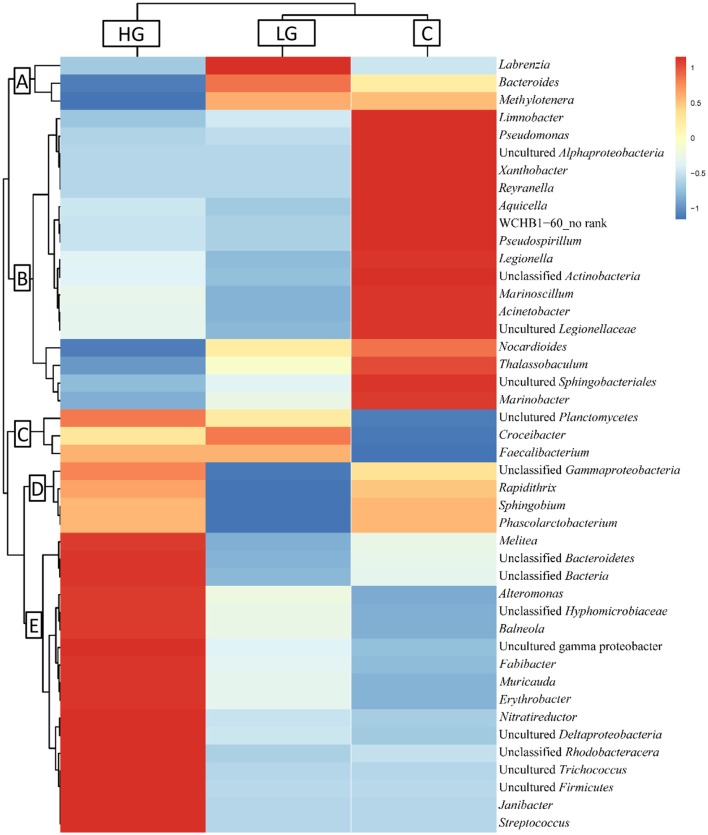
Hierarchical clustering of V4-V5 region of 16S rRNA gene based on microbiota compositions. Forty-four phylotypes were classified as differentially abundant and grouped by similarity of patterns. The spectral percentage for each phylotype was averaged across treatments (C, LG, and HG). Red color indicates increased abundance while blue indicates reduced abundance. Letters (A-E) indicate clusters of similar pattern.